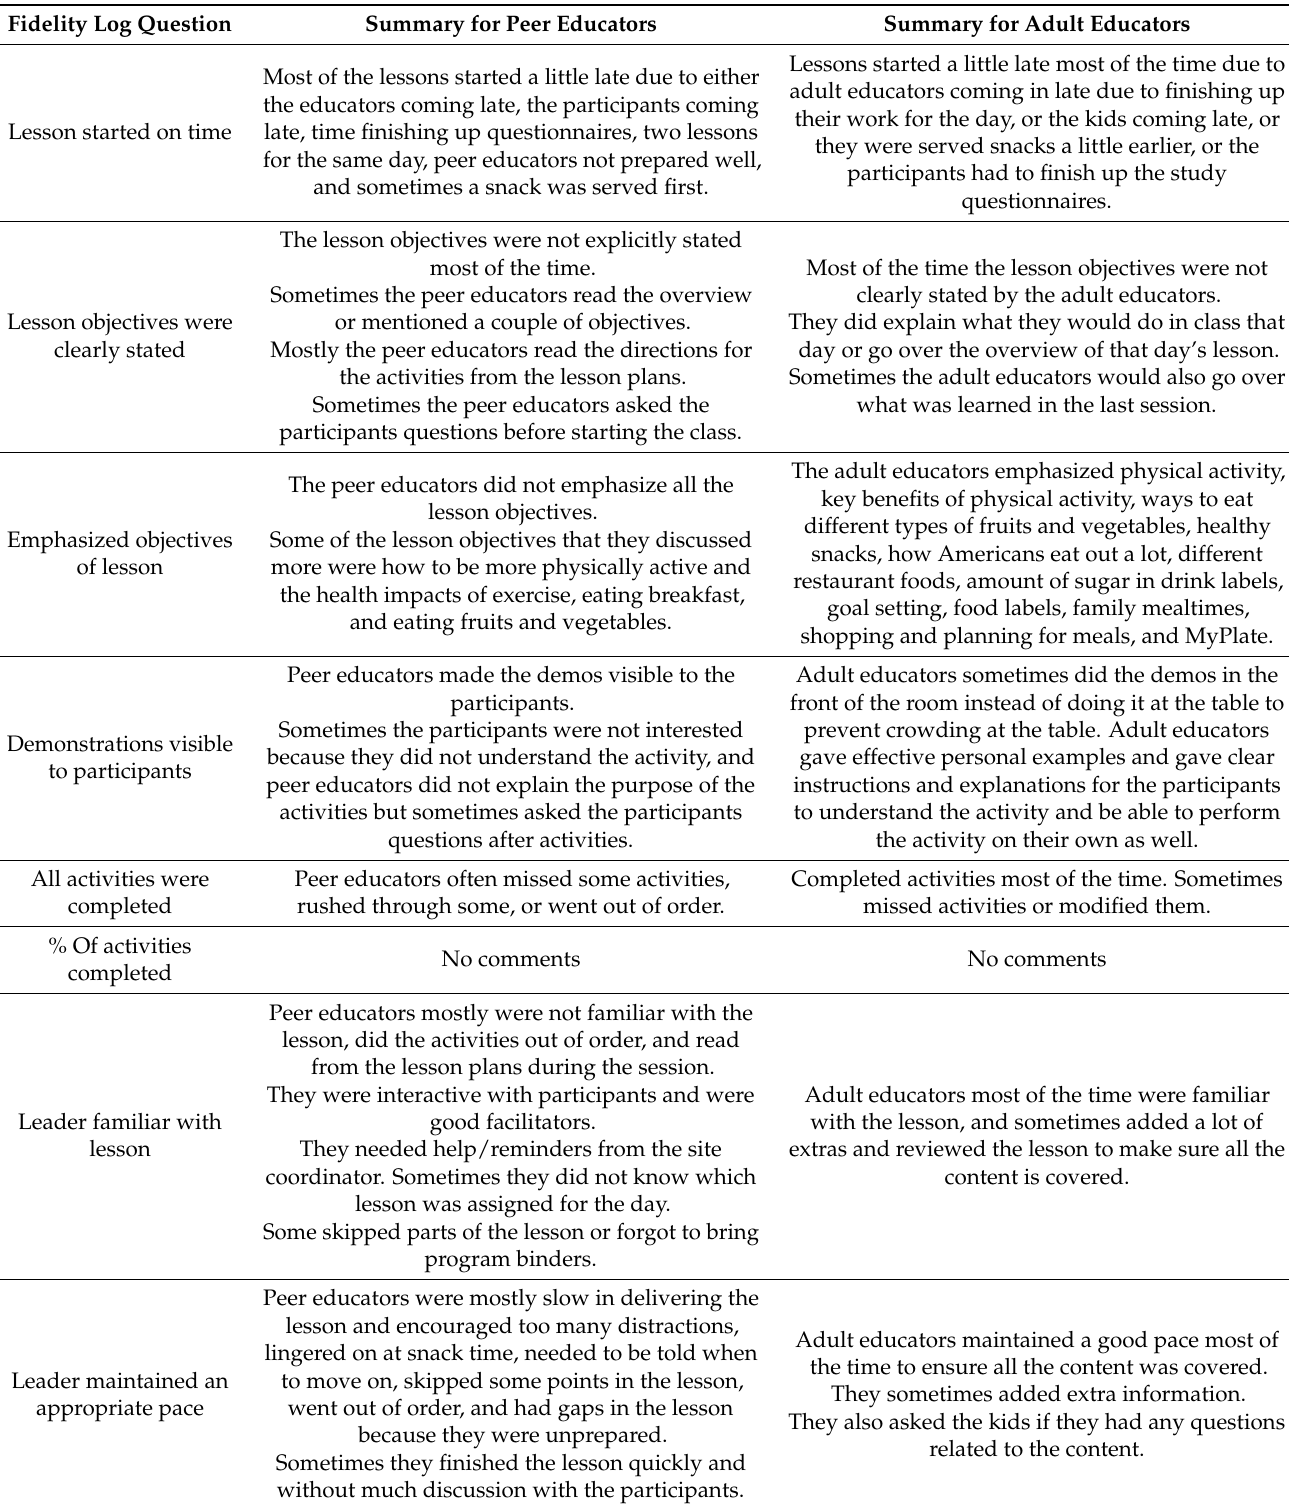
Table 4. Summary of university student comments for fidelity log questions for peer- and adult-led sessions. Fidelity Log